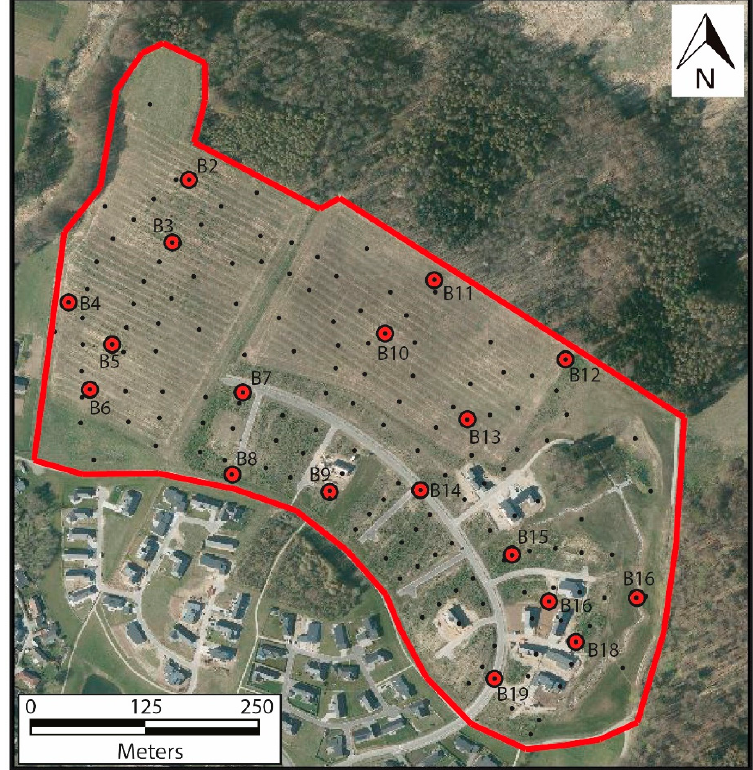
Figure 6. Overview map showing drillings (black dots) and infiltration test (red dots).